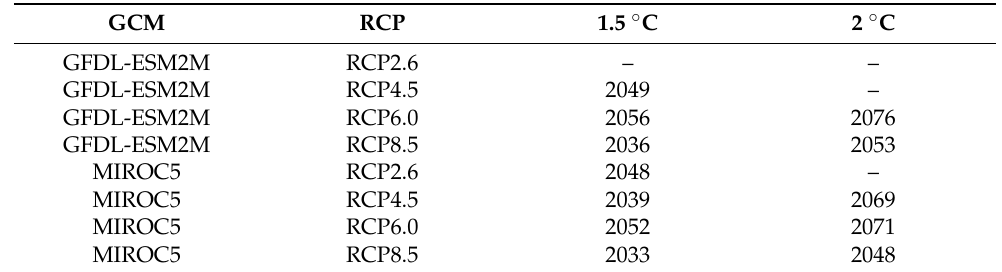
Table 2. Years of reaching global warming thresholds of 1.5 ◦ C and 2 ◦ C relative to pre-industrial values for different GCMs and